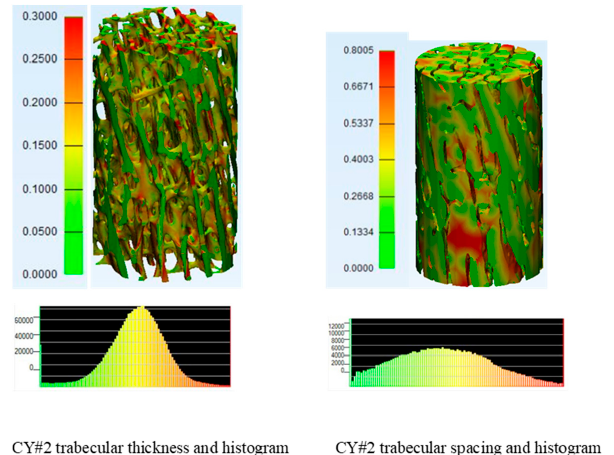
Figure 9. Trabecular thickness and trabecular spacing colored maps and histograms for cylindrical bone sample CY#2.